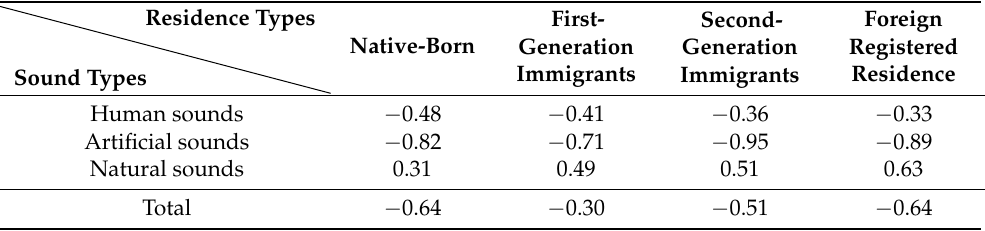
Table 7. The evaluation results of the degree of correlation between soundscapes. TypesResidence Sound